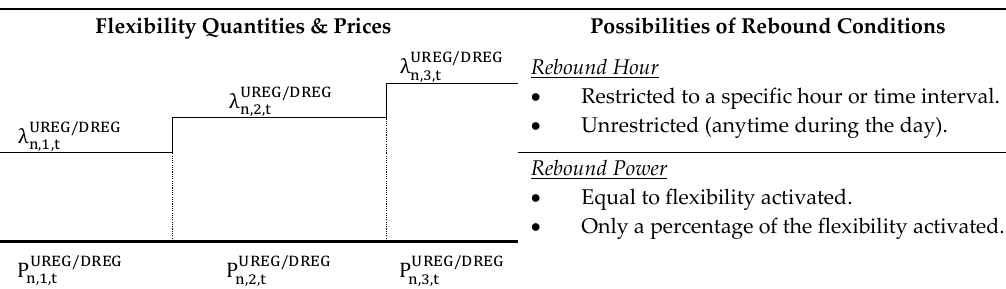
Figure 1. Flexibility market framework (only shaded blocks are addressed by the paper). Table 3. Flexibility bids components.